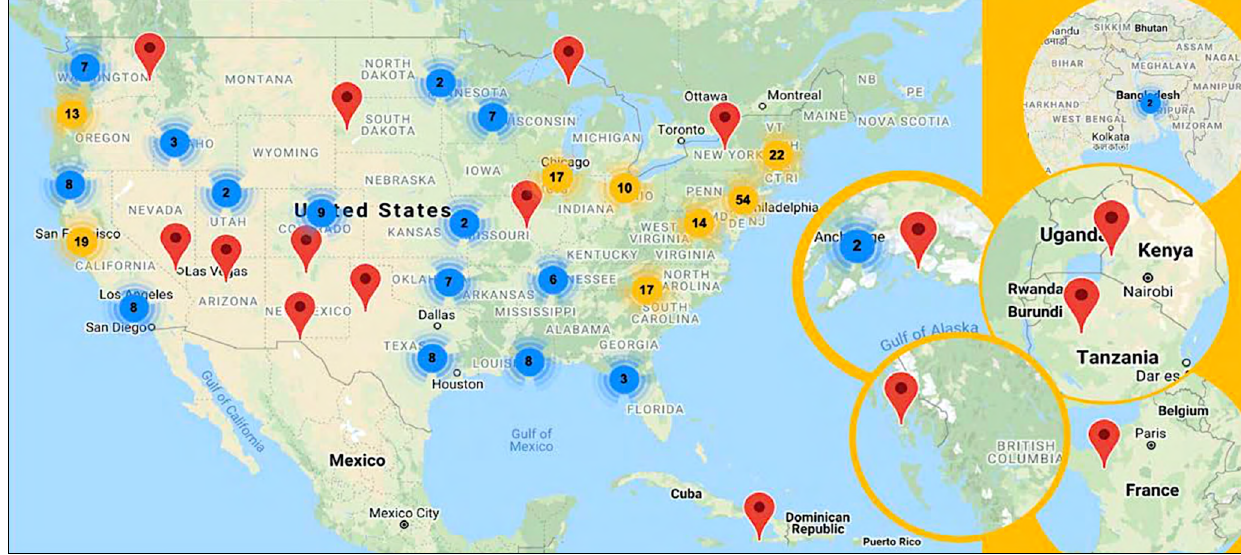
Figure 4 Cooperative Gardens Commission resource-sharing map, 2020.